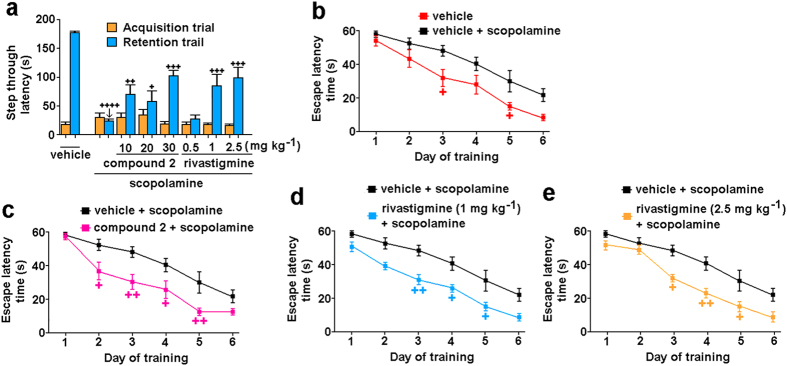
Effects of compound 2 and rivastigmine on scopolamine-induced memory impairment in the passive avoidance (a) and the Morris water maze tasks (b–e). (a) Data are mean step-through latencies ± SEM (n = 9–10 mice per group). Significance: +p < 0.05; ++p < 0.01; +++p < 0.001; ++++p < 0.001, versus scopolamine-treated control (in the retention phase). (b–e) Learning curves showing acquisition phase for vehicle-treated mice and scopolamine-treated control mice (b), scopolamine-treated control mice and scopolamine-induced memory-impaired mice treated with 30 mg kg−1 compound 2 (c), or 1 mg kg−1 (d) or 2.5 mg kg−1 (e) rivastigmine. Data are mean escape latency ± SEM from four daily trials. Significance versus scopolamine-treated control: +p < 0.05; ++p < 0.01.